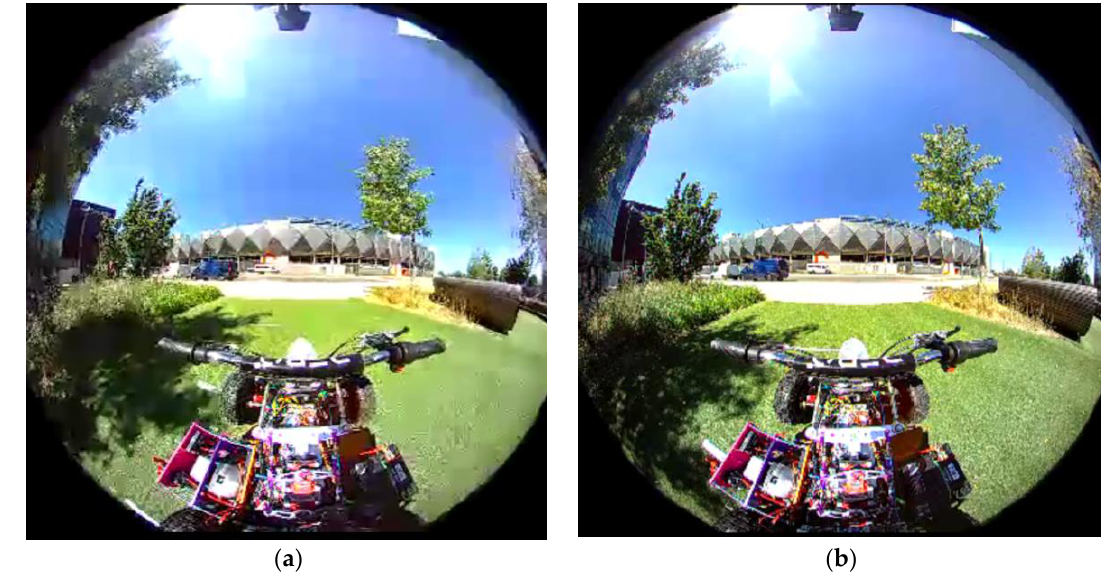
Figure 14. The effect of motion artefacts on video capture. ( a ) When the vehicle in motion; ( b ) When the vehicle is still.